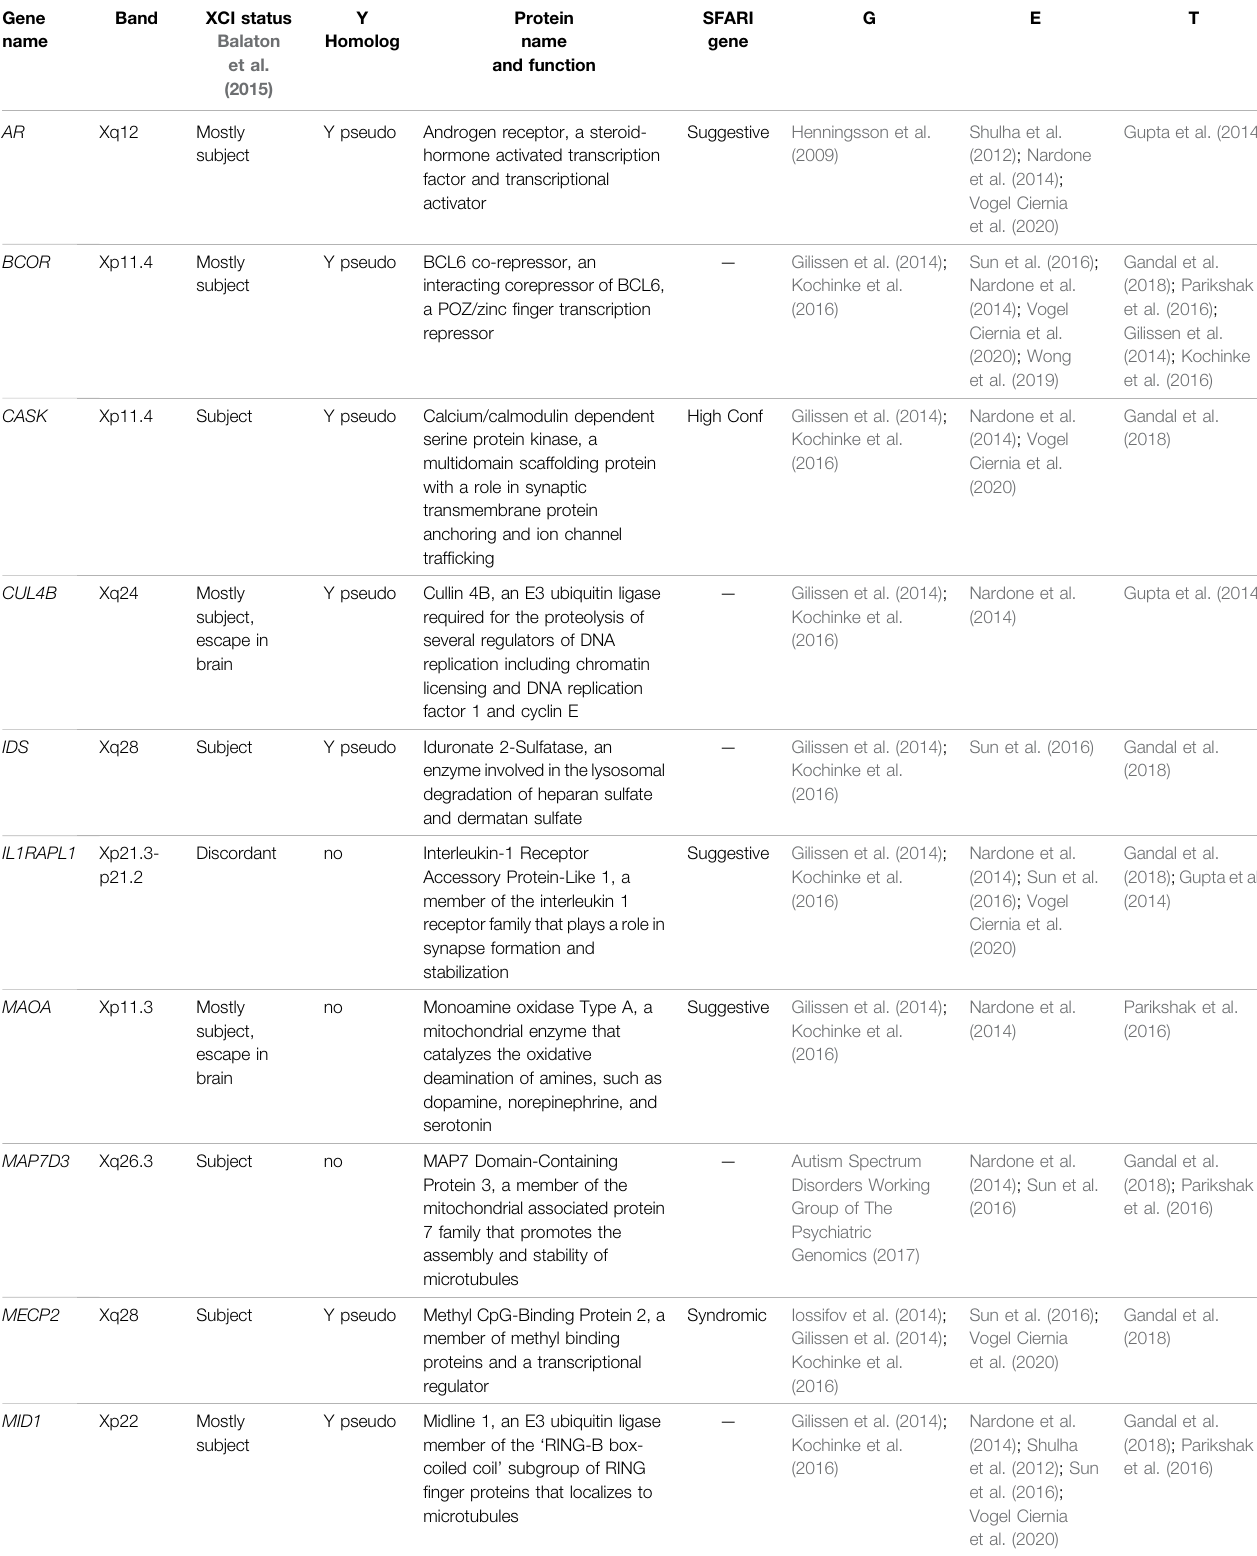
TABLE 1 | X-linked genes and their functions with triple-level multi-omic implication in ASD (G = genetic, E = epigenetic, T =